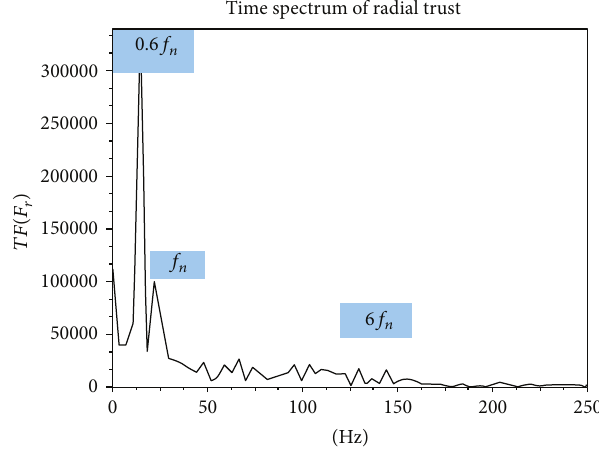
Figure 15: Spectrum of the fluctuations of radial thrust.